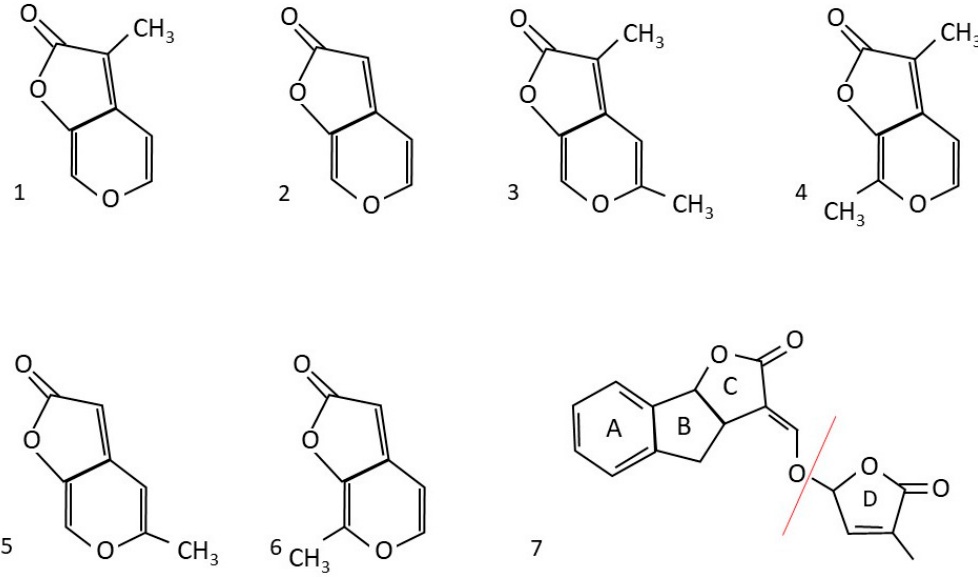
Figure 1. The known chemical structures of karrikin family representatives and strigolactone analog GR24. 1. KAR 1 2. KAR 2 . 3. KAR 3 , 4 KAR 4 , 5. KAR 5 , 6. KAR 6, 7. Strigolactone analog GR-24, the red line separates a lactone D ring, which is similar to the KARs butenolide ring.